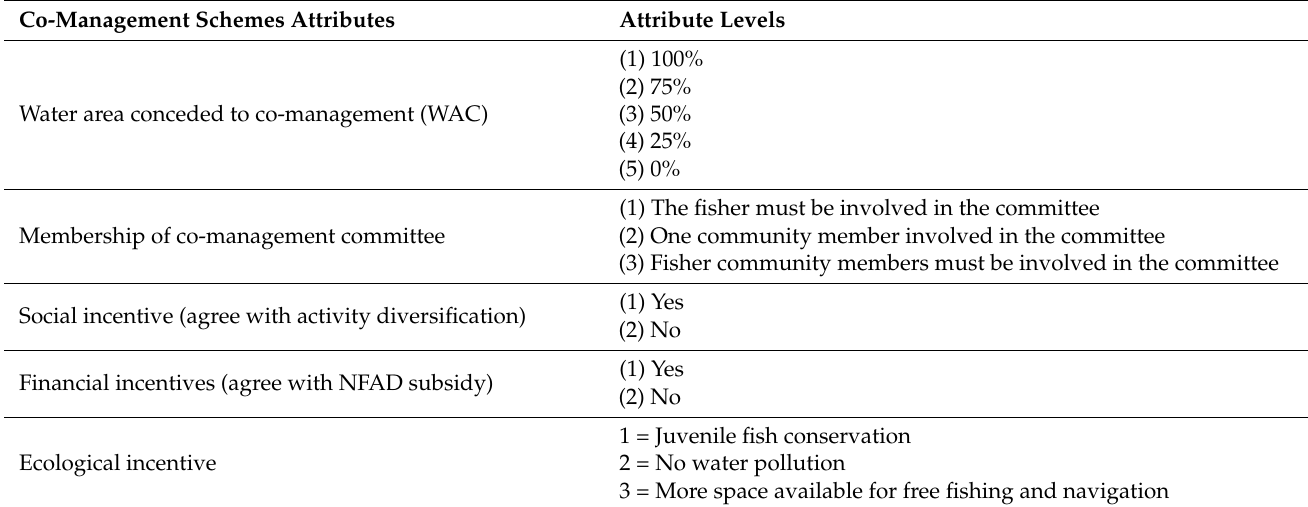
Table 1. Selected co-management committee attributes and attribute levels.